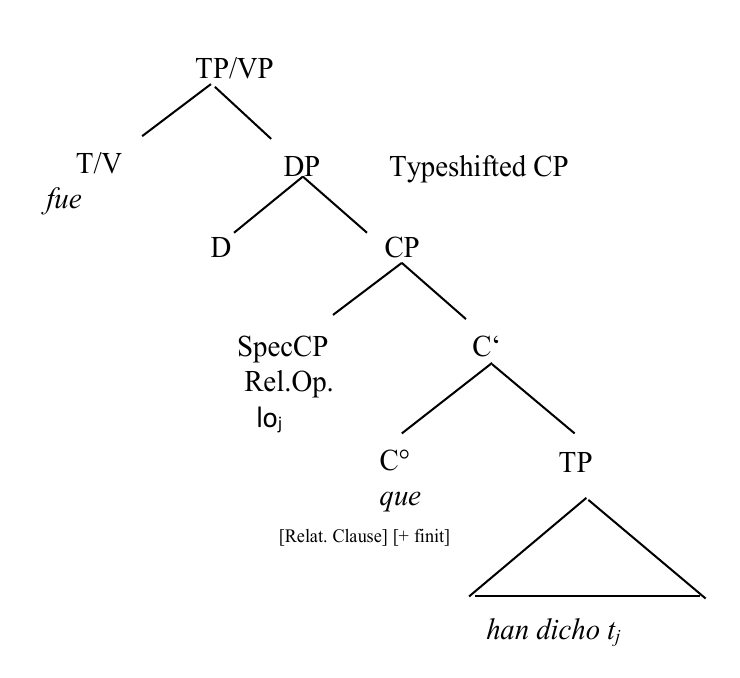
SFRs under ser-predicate in Modern